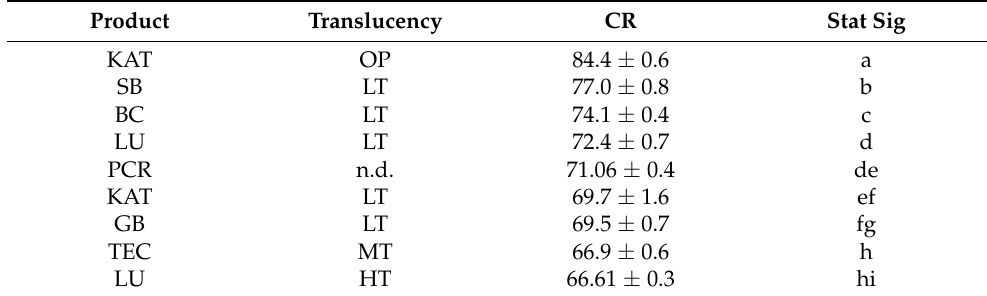
Table 2. Contrast Ratio (CR) of the materials tested. Materials are listed from the highest CR (opaquer) to the lowest CR (more